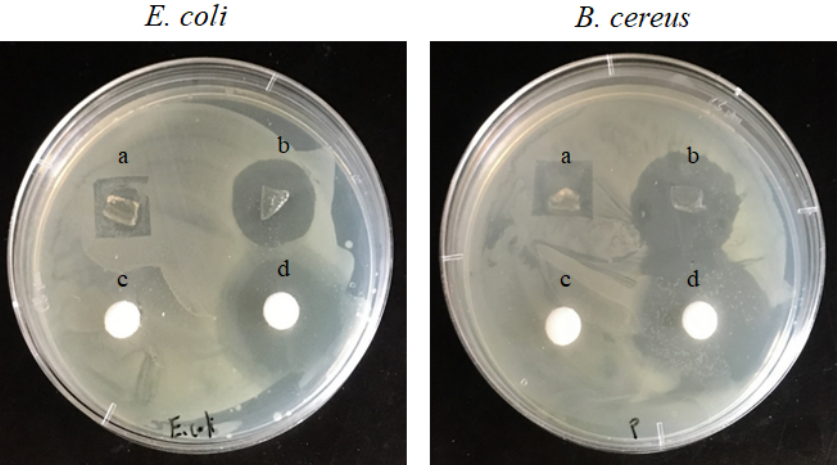
Figure 9. Antibacterial activity of prepared nanofibers showing the zone of inhibition against E. coli and B. cereus after 8 h of incubation at 37 °C: ( a ) 1J12P1T305; ( b ) dexamethasone and ampicillin loaded JFP/pullulan nanofibers; ( c ) cotton; and ( d ) ampicillin.